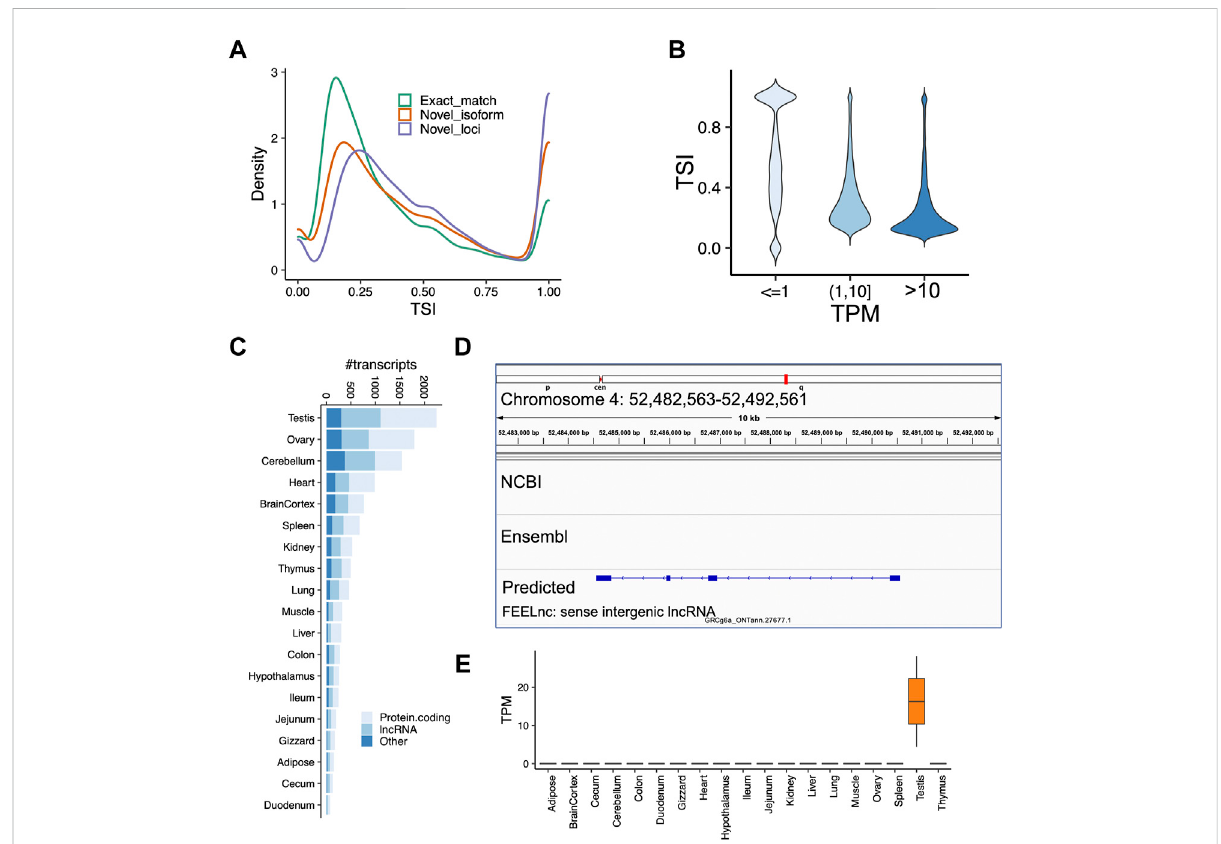
FIGURE 4 Analysis of tissue-speci fi city across tissues. (A) Tissue speci fi city index (TSI) as a function of different types of transcripts classi fi ed by GffCompare.Code “ = ” meanstheintronchainsofourannotatedtranscriptscanexactlymatchtoreferenceannotations(Exactmatch);Codes ‘ c, ’‘ k, ’ ‘ j, ’‘ m, ’‘ n, ’ or ‘ o ’ meanpredicted transcript cannot match areferencetranscriptbut canmatch areference gene(Novelisoform);Codes ‘ i, ’‘ u, ’‘ y, ’ or ‘ x ’ means predicted transcript cannot match either a reference transcript or a reference locus (novel loci). (B) Transcript expression measured as transcript per million (TPM) as a function of TSI. We grouped transcripts according to their expressions. (C) Number of tissue-speci fi c transcripts in each tissue. (D) A screenshot showing a novel transcript only predicted by our data, which is located on chromosome 4 (52,482,563 – 52,492,561). (E) TPM expressions of thepredicted lncRNA transcript shown in thepanel (D) . The transcript is highly expressed intestes samples, but not any other tissue. The FEELnc predicted it as a sense intergenic